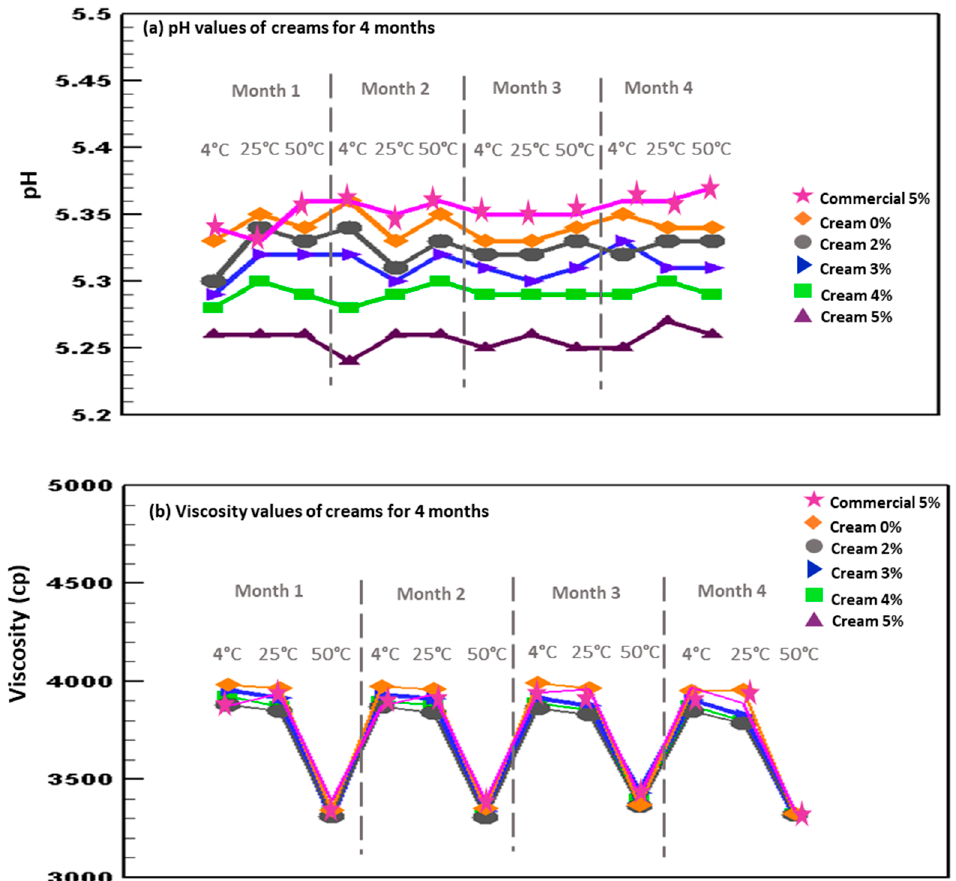
Figure 6. Values of pH ( a , upper panel) and viscosity ( b , lower panel) of creams, containing 0, 2, 3, 4, 5%, Marselan extract, or 5% of the commercial extract, and stored for 4 months at 4, 25 and 50 °C. The pH of the samples was also determined at different storage temperatures over a period of 4 months: 4 ◦ C (fridge), 25 ◦ C (room temperature), and 50 ◦ C (oven) (Figure 6a, upper panel). The pH of the creams containing the extracts (Marselan or the commercial one) maintained their stability (~5.3) during the four months of evaluation and did